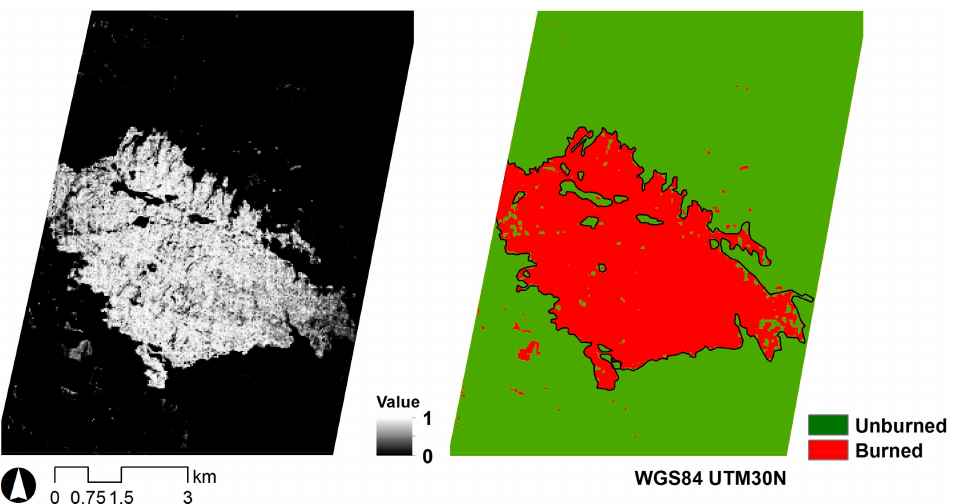
Figure 3. Left: Maximum Entropy (MaxEnt) probability output (0: 0% probability; 1: 100% probability); right: burned area